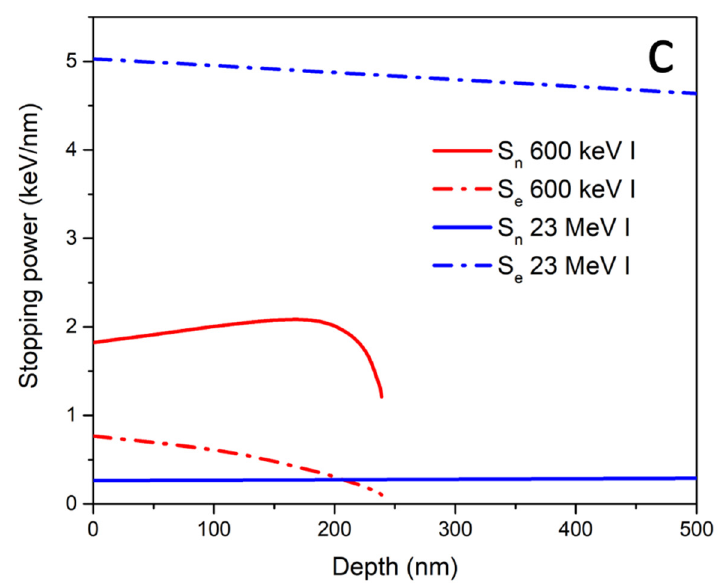
Figure 1. ( a ) RBS/c spectra obtained from the sequentially irradiated silicon sample. Damage in silicon is observed after 600 keV I irradiation up to a fluence of 10 14 ions/cm 2 as a pronounced damage peak at proton energies between 830–880 keV. After irradiation of damaged Si with a 23 MeV I beam up to a fluence of 10 14 ions/cm 2 , recovery of the damage can be observed as a decrease of the same peak. ( b ) Disorder fraction depth profiles obtained by the two-beam approximation method. Additionally, the damage depth profile obtained by SRIM is also given [23]. ( c ) Nuclear and electronic stopping powers of silicon for the iodine projectiles used [23].